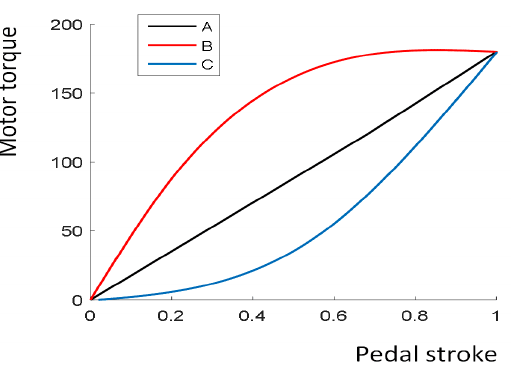
Figure 9. Function relation of accelerator pedal opening and motor torque.